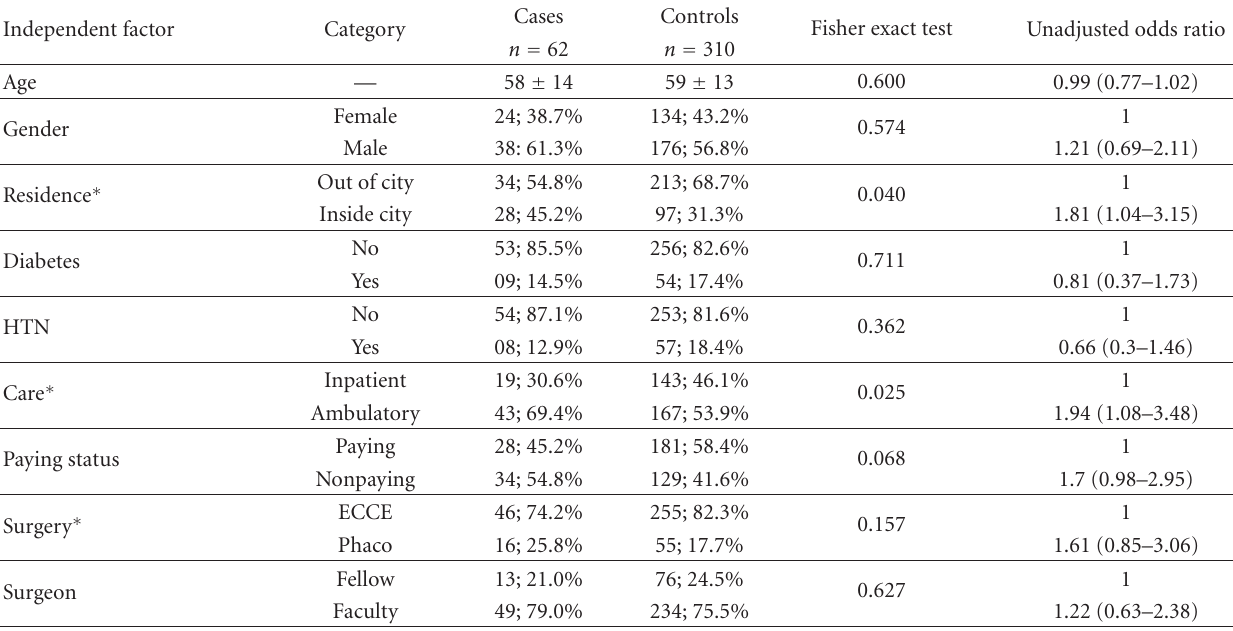
Table 3: Distribution of exposure factors between cases of endophthalmitis and their controls (univariate analysis).